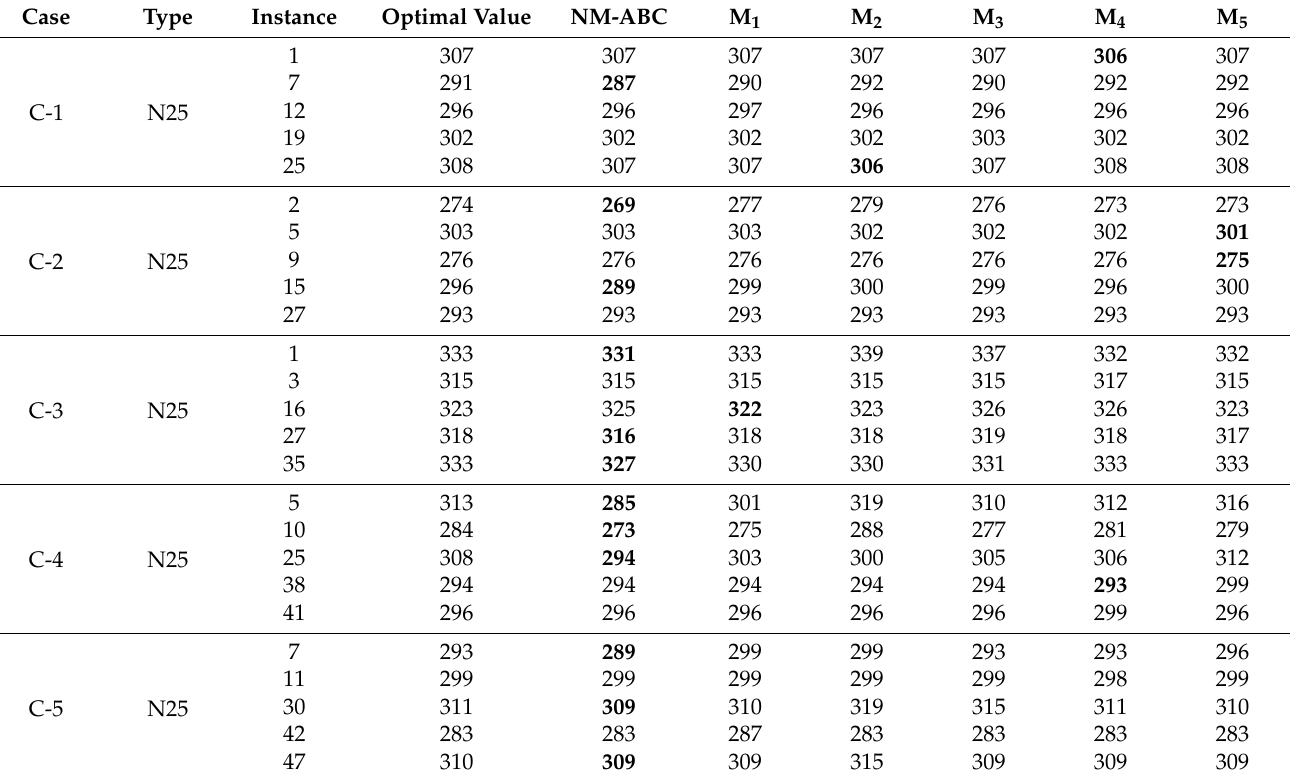
Table 3. Summary of the Best result obtained by proposed Artificial bee colony with Nelder Mead method (NM-ABC) and competitor